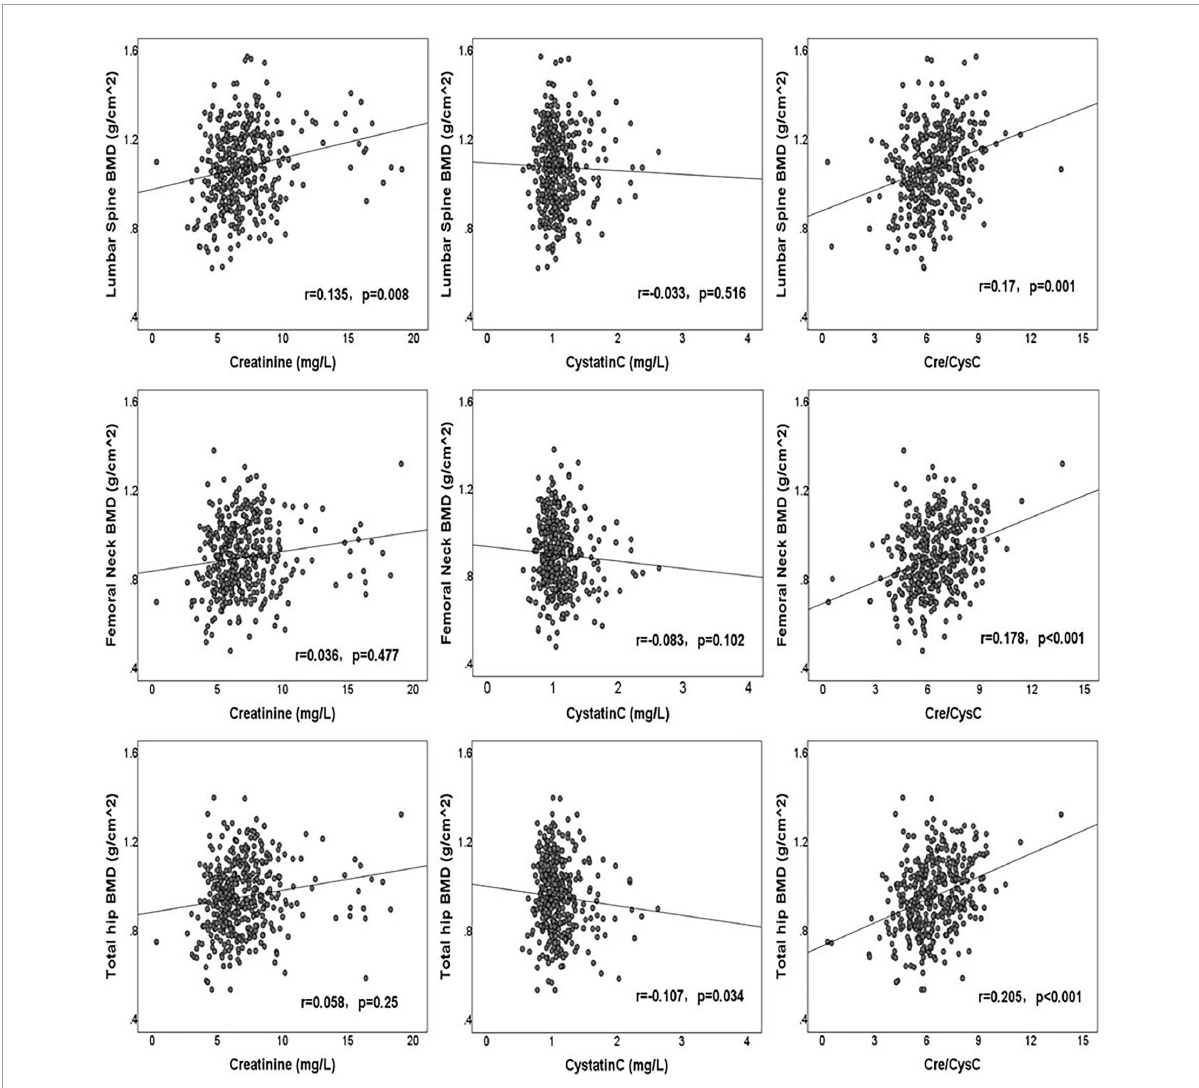
FIGURE1 Scatter plot of creatinine, cystatin C, creatinine/cystatin C, and